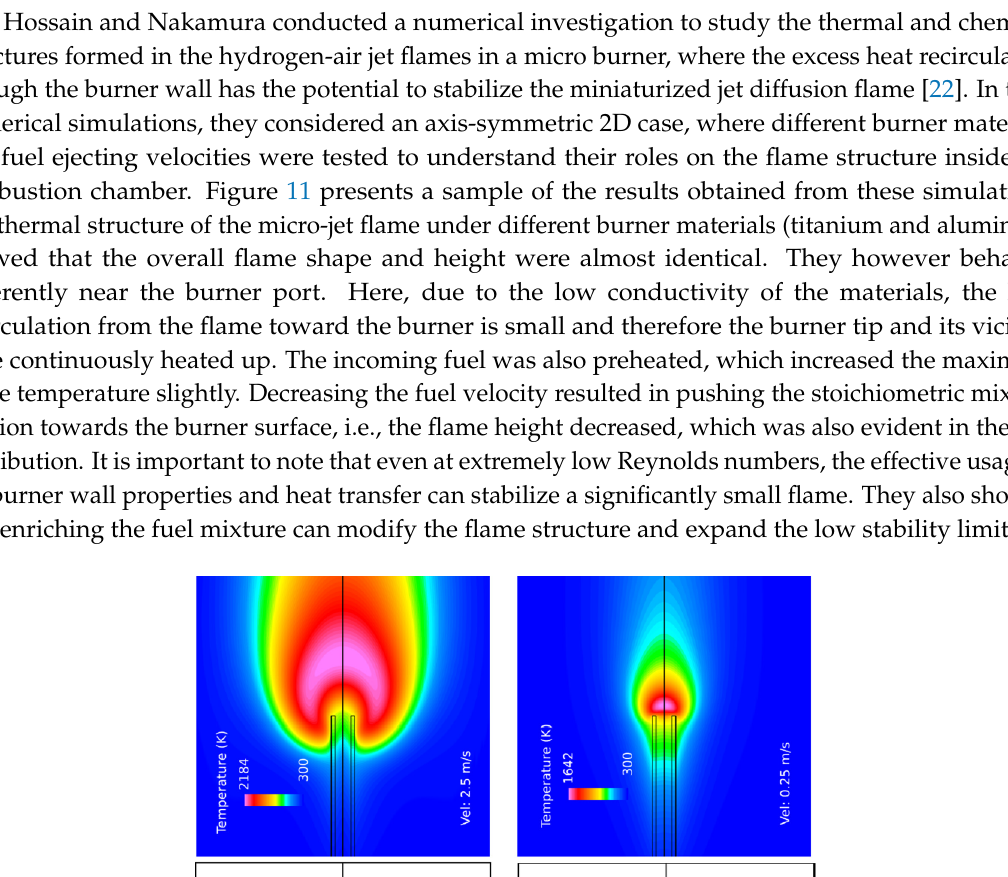
Figure 10. Modeled quenching limits of hydrogen diffusion flames by Lecoustre et al. [20]. Flame structure ( a ) and local heat release rates ( b ) for a large H2/air normal flame on a 5 mm radius burner.